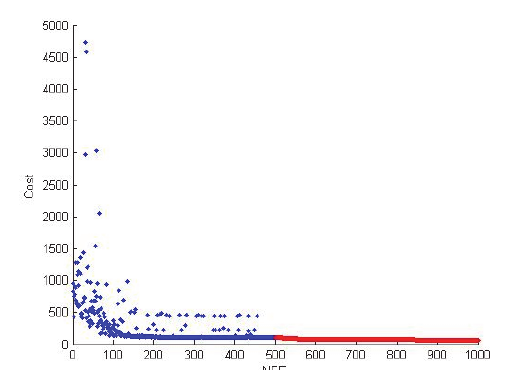
Fig. 9. The average weighted cost of hybrid algorithm in large